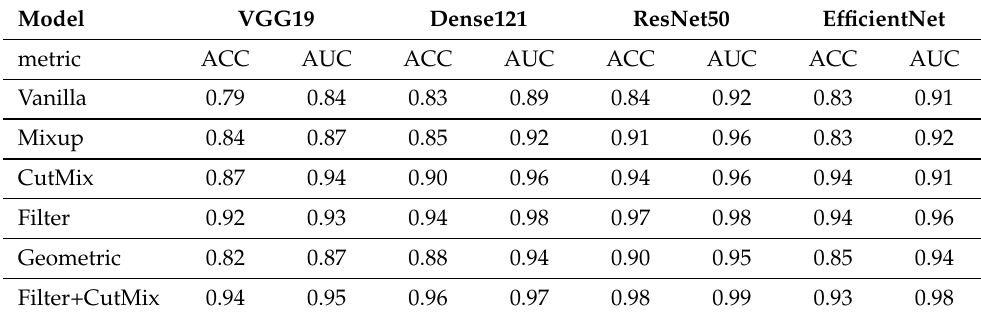
Table 9. ACC and AUC of Histopathology according to Data Augmentation